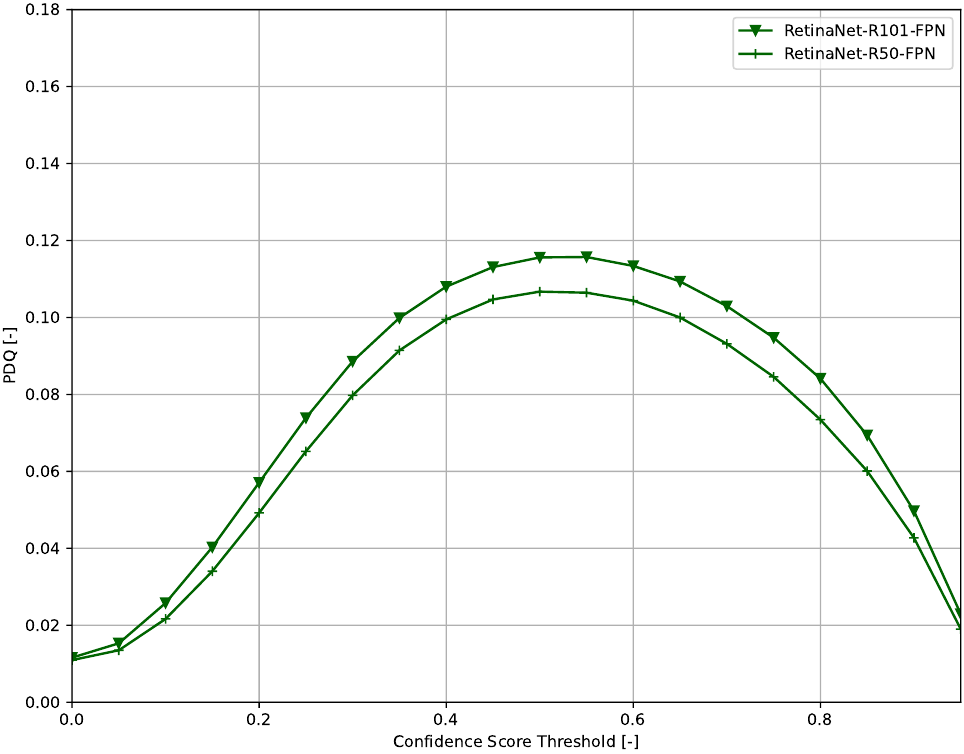
Figure 11. PDQ results of RetinaNet on the COCO